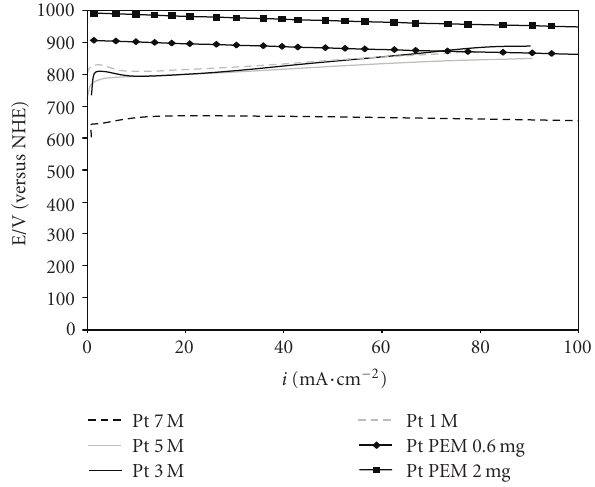
Figure 9: Cathode polarization curves for Pt MEA for a DMFC at 60 ◦ C fed with 1, 3, 5, and 7M methanol solution with air operation compared to experimental (0.6mg) and predicted (2.0mg) data